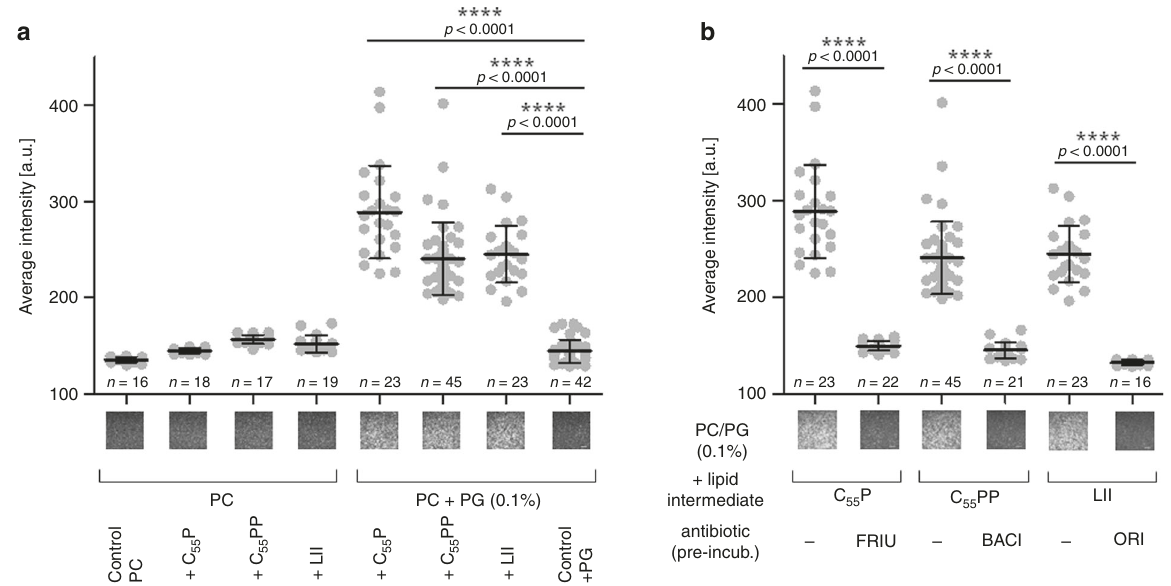
Fig. 4 DAP binding to supported bilayers doped with cell wall lipid intermediates. a Binding of DAP to supported bilayers is drastically increased in presence of bactoprenyl-coupled lipid intermediates and PG. Supported planar bilayers were prepared on coverslips using neutral DOPC lipids. Negatively charged PG lipids and bactoprenyl lipids were added, either 0.1 mol% bactoprenyl-coupled lipid intermediates or mixtures with PG (0.1 mol% each, 0.2 mol % PG served as a control). DAP was applied as a mixture of 1 µ M native DAP and 50 nM DAP-FL. Movies with 100 frames were recorded at a frame rate of 60 Hz within 3 min after addition of DAP. The movies allowed to discern single binding events of DAP-FL. Exemplary fl uorescence images are shown for each mixture. The fi eld of view corresponds to (32.5 µ m) 2 . b Inhibition of DAP-FL binding to supported planar bilayers (PC + 0.1% PG) by antibiotics that target speci fi c bactoprenyl-coupled lipid intermediates. 300 nM of each antibiotic (FRIU, friulimicin; BACI, bacitracin and ORI, oritavancin) were incubated with the corresponding bactoprenyl-coupled lipid intermediate containing membranes for 5 min (antibiotic:lipid intermediates ratio 100:1). Excess of antibiotics was removed by buffer exchange followed by the addition of DAP as described in a . Exemplary movies are shown in Supporting Movies 2 and 3. Data were obtained from at least 20 movies for each experiment. We determined the mean values in a fi eld of 160 µ m 2 in the fi rst image of each movie. Data in a and b are plotted as averages of these means and error bars represent the SD of all movies of a speci fi c experiment. Signi fi cance was determined by unpaired Student ’ s t -test with a 95% con fi dence interval, **** p < 0.0001. All experiments were independently repeated three times and yielded comparable results. Source data are provided as a Source Data fi